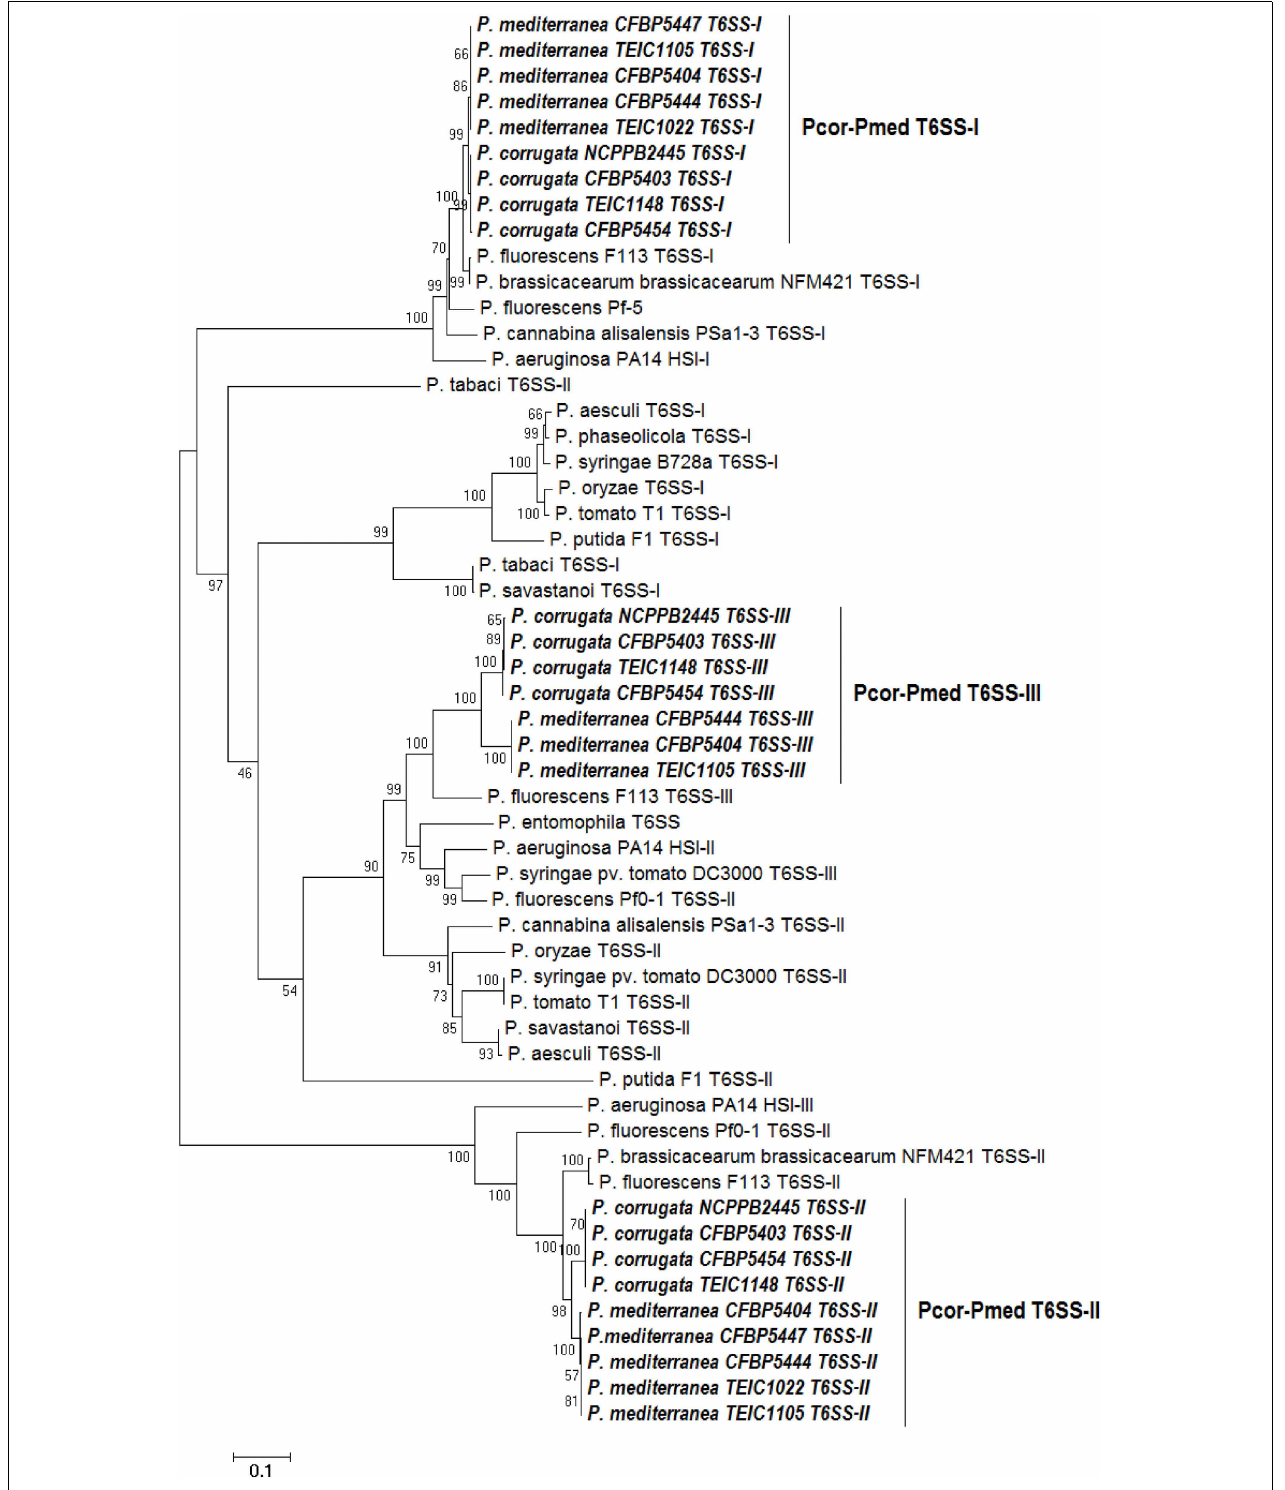
FIGURE 6 | Distance tree of T6SSs of various pseudomonads based on the sequence of four T6SS core proteins (ImpC, ImpG, ImpH, and ImpL). The evolutionary history was inferred using the Neighbor-Joining method (Saitou and Nei, 1987). The bootstrap consensus tree inferred from